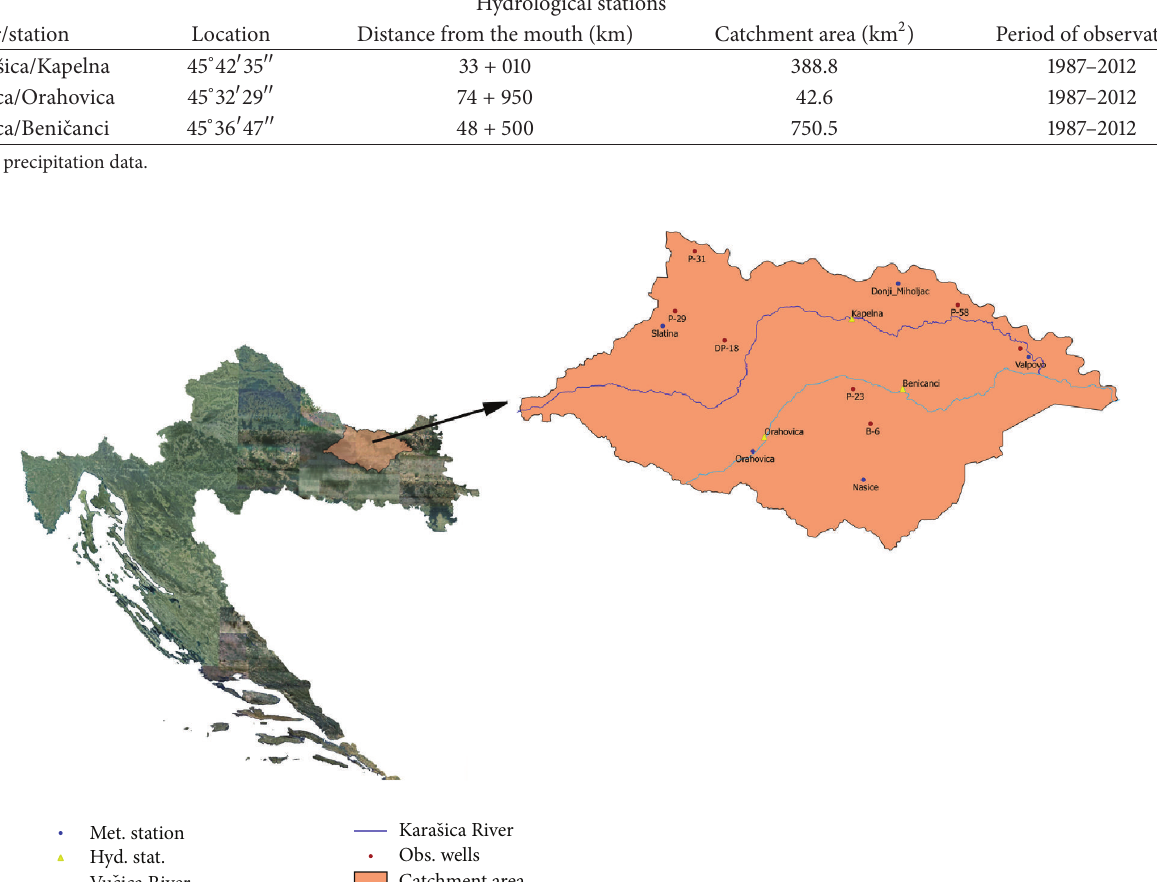
Figure 1: Catchment area with meteorological and hydrological